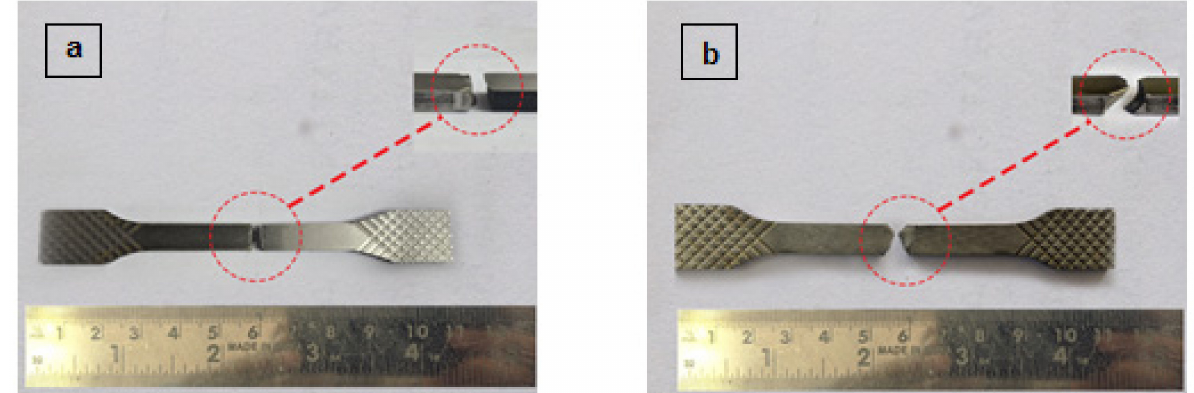
Figure 11. Sample after fatigue failure ( a ) Dry grinding ( b ) Cryogenic grinding.